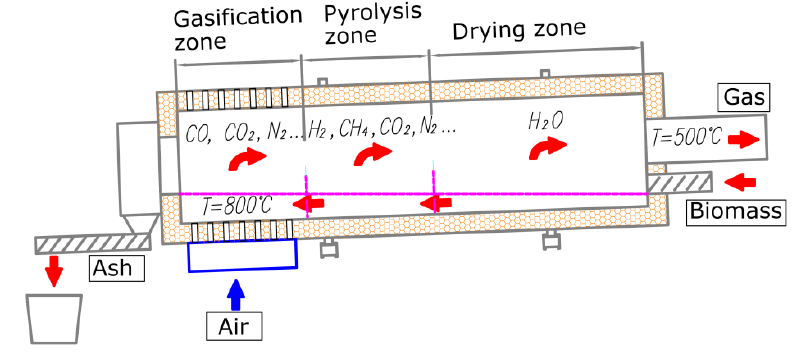
Figure 1. Biomass gasification chamber